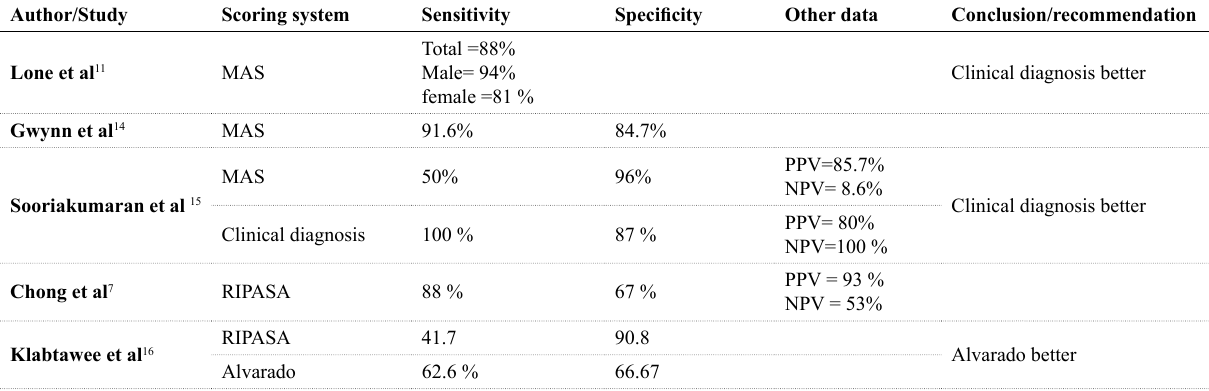
Table 7: Comparison of accuracy of different scores by various